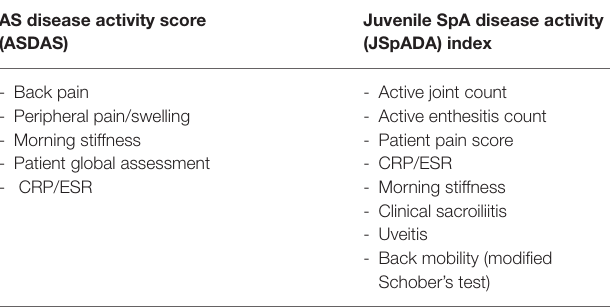
TABLE 2 | Comparison of adult and paediatric disease activity scores for SpA. AS disease activity score